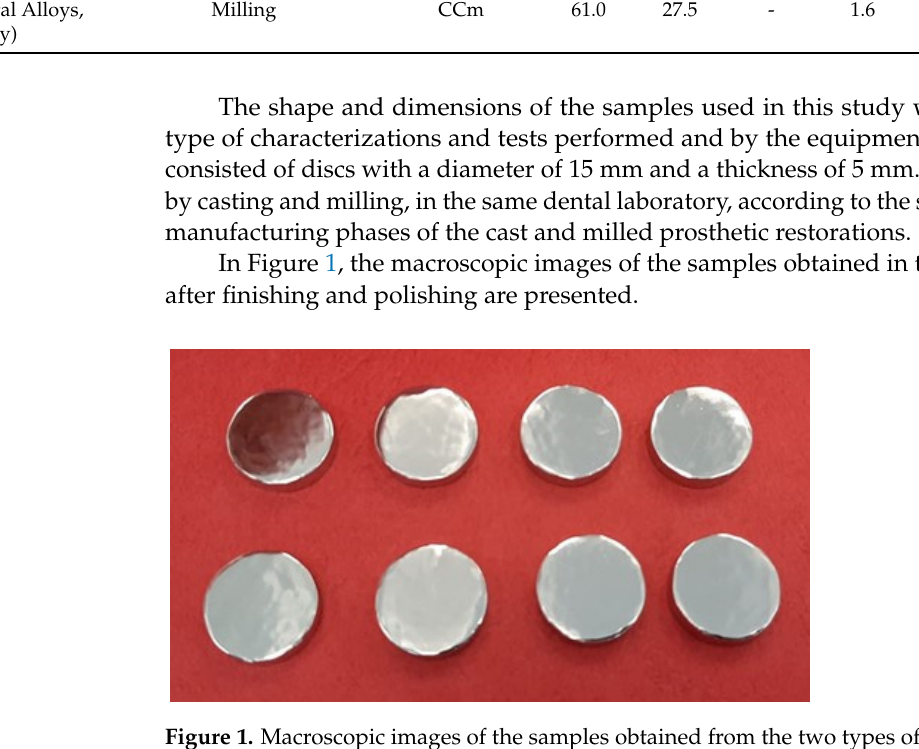
( b ) Figure 2. SEM images of the CCc (cast Co-Cr alloy) sample surface at: ( a ) 500×; ( b ) 3000×. Compared to the cast Co-Cr alloy (CCc), the one manufactured by milling (CCm) did not present dendrites, and only some very thin scratches from the milling process (in or- der to obtain the desired shape), and non-metallic inclusions (black colored circular